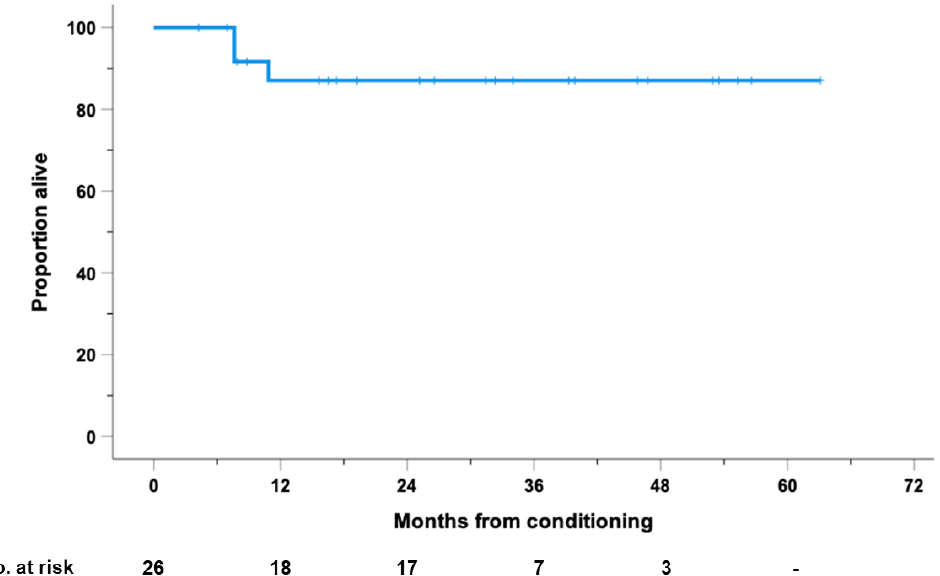
OS rates of 87% (95% CI: 73 to 100) (Figure 4).